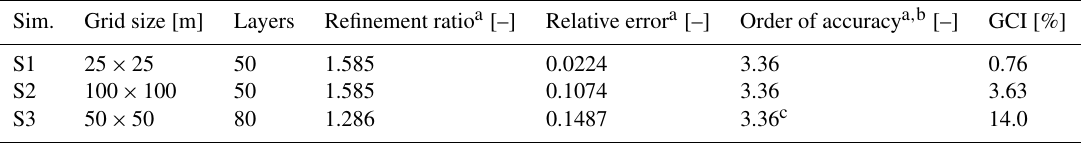
Table A1. Grid convergence index (GCI) of the simulated increase in the volume of fresh groundwater in 2050 (situation with Sand Engine), for three simulations that contain different spatial grid refinements (S1 to S3).